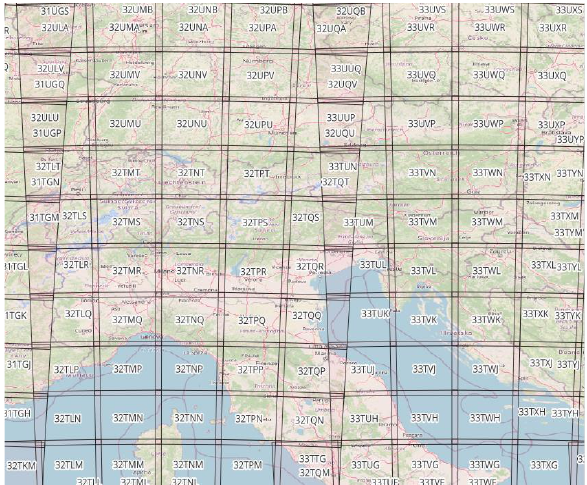
Figure 1. Tiles from Sentinel-2 granules’ footprints, with tile coding where the first two digits show the UTM zone and letters the code.